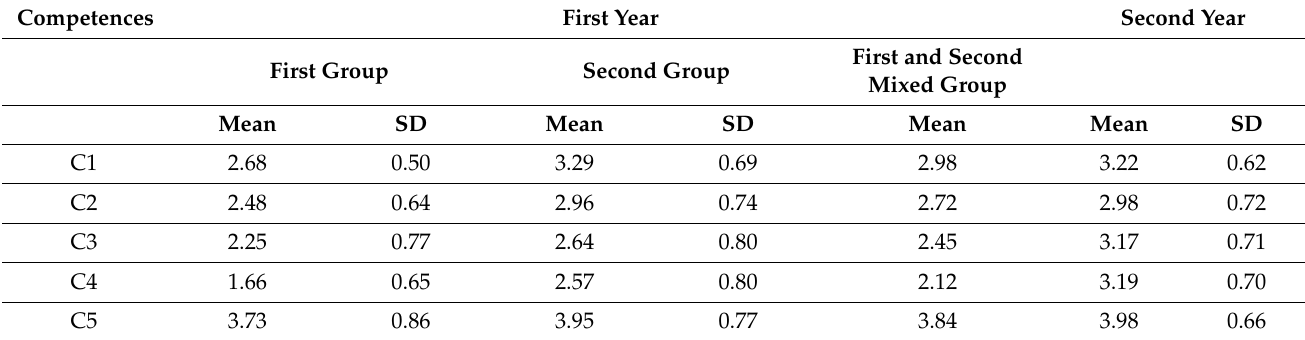
Table 7. Comparison of the first year vs. second year competent